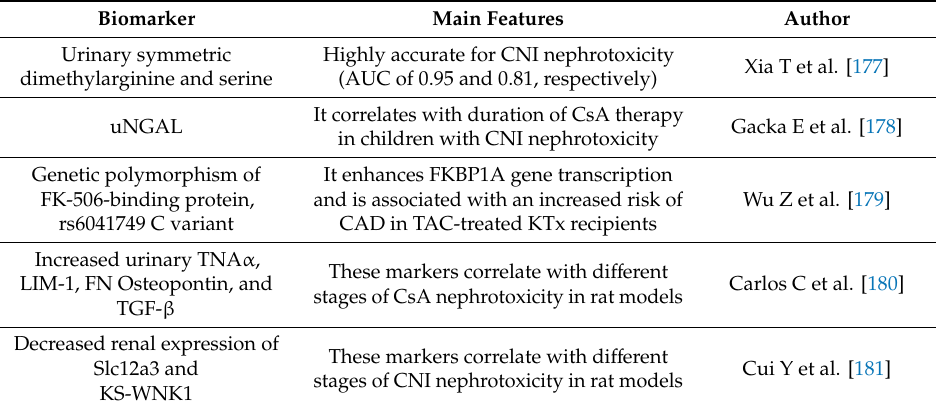
Table 9. Potential biomarkers for chronic calcineurin-inhibitor (CNI)